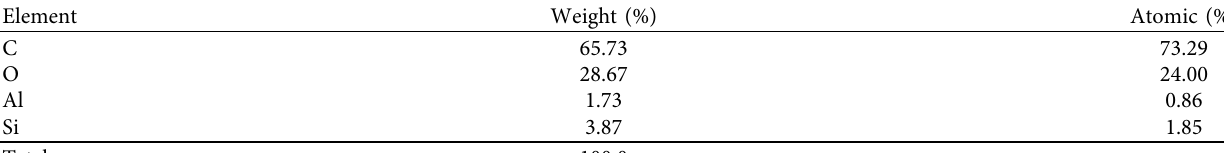
Table 1: EDX results of PVB/bentonite nanofbers.